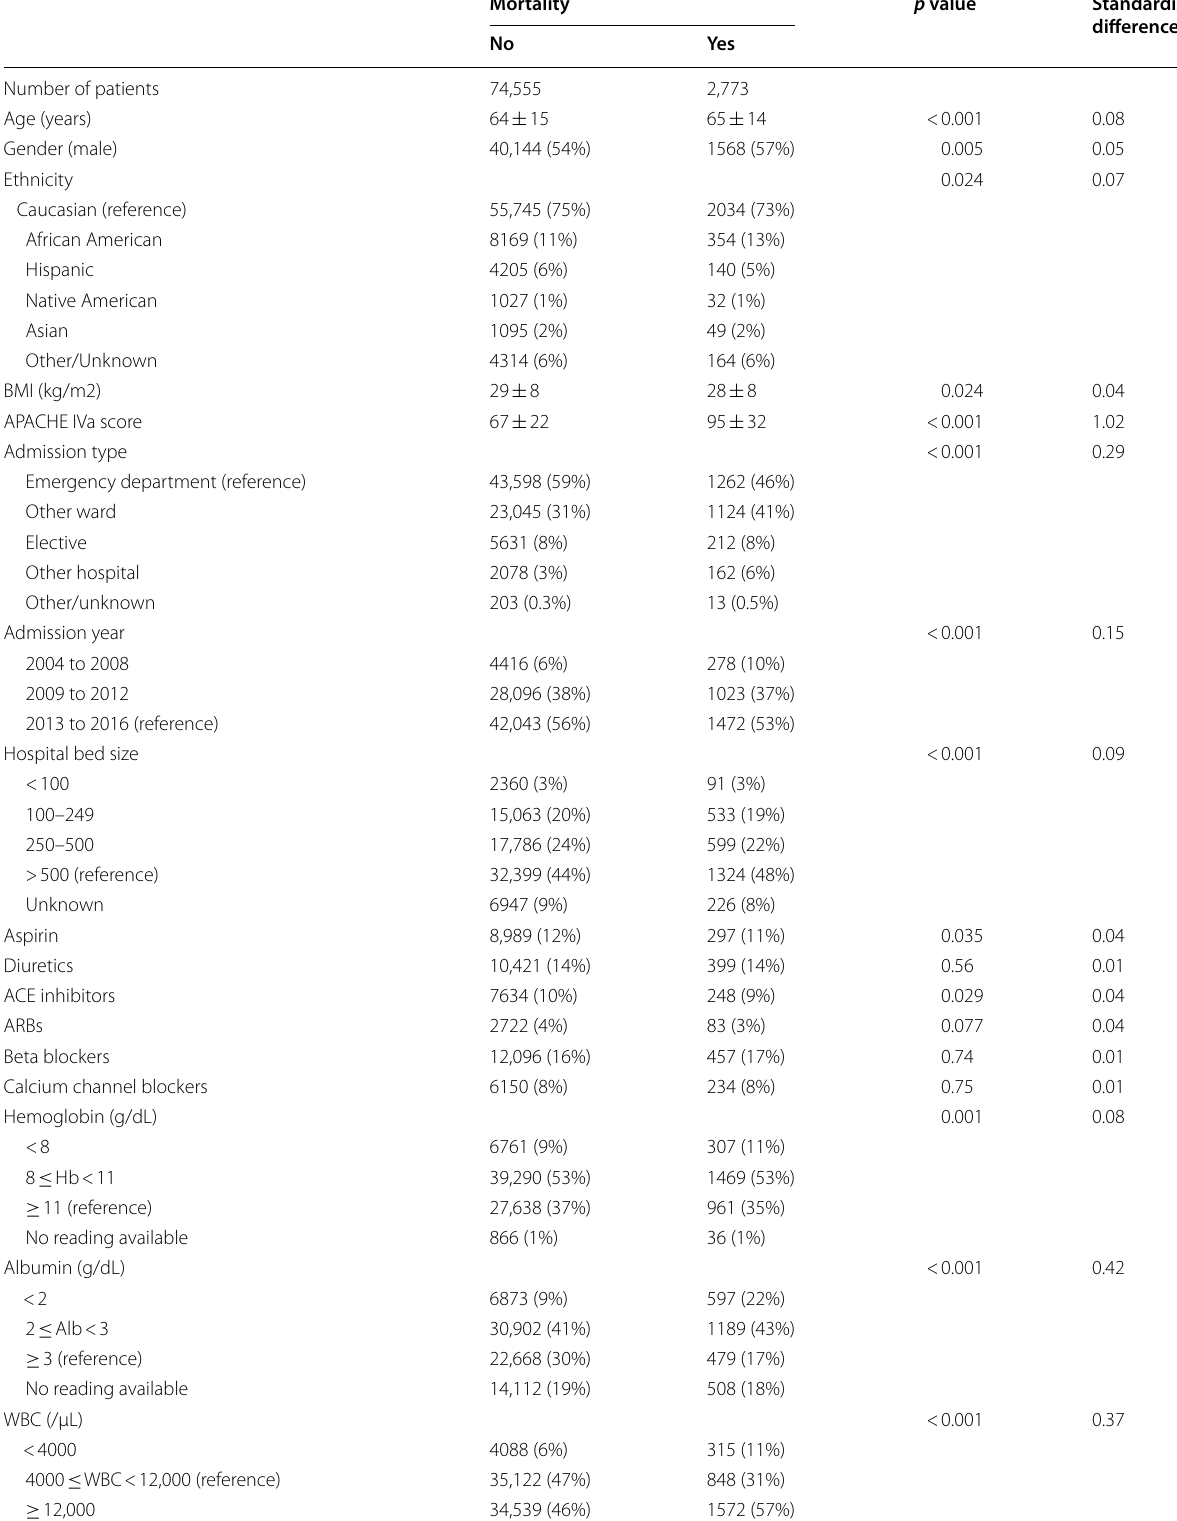
Table 1 Baseline characteristics and hypotension exposure in septic ICU patients Mortality p value Standardized